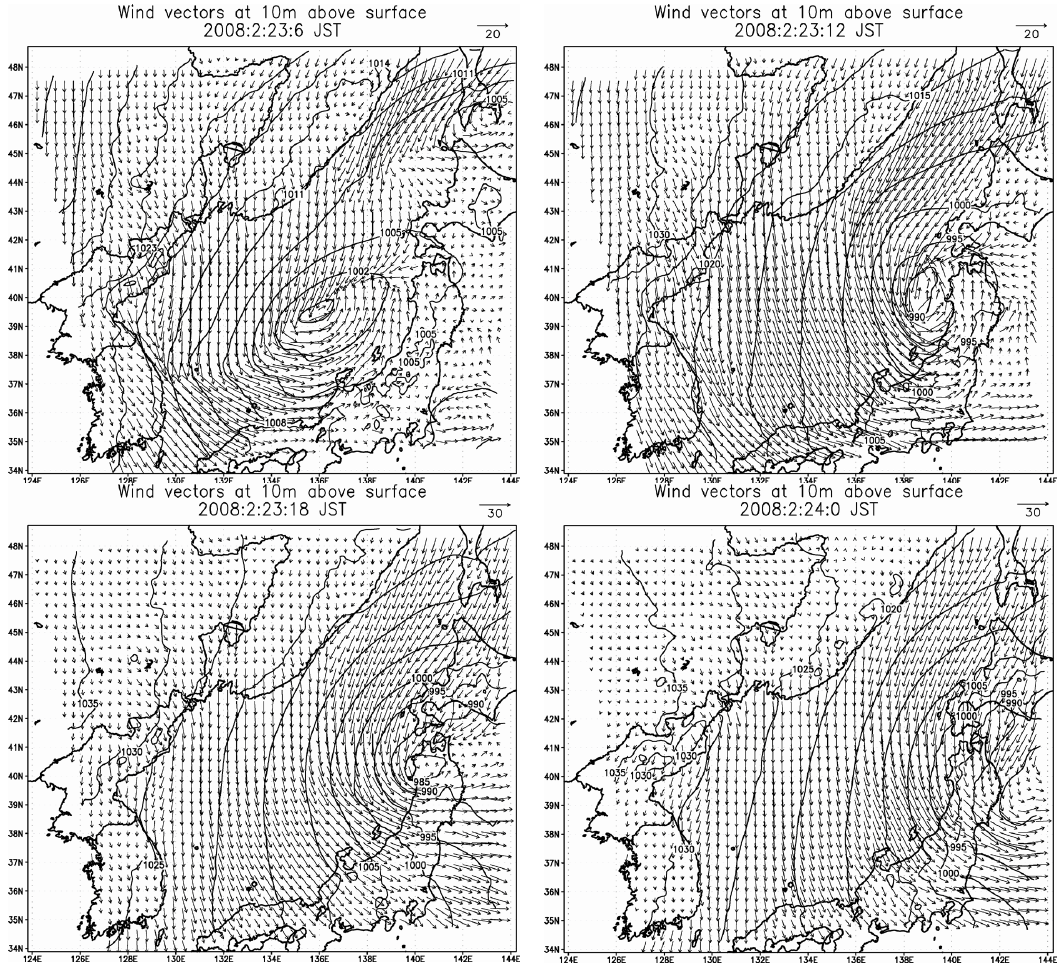
Fig. 12. Calculated wind vectors and isobars from domain 2 for six hour increments from 21:00 UTC 22 February to 15:00 UTC 23 February 2008.